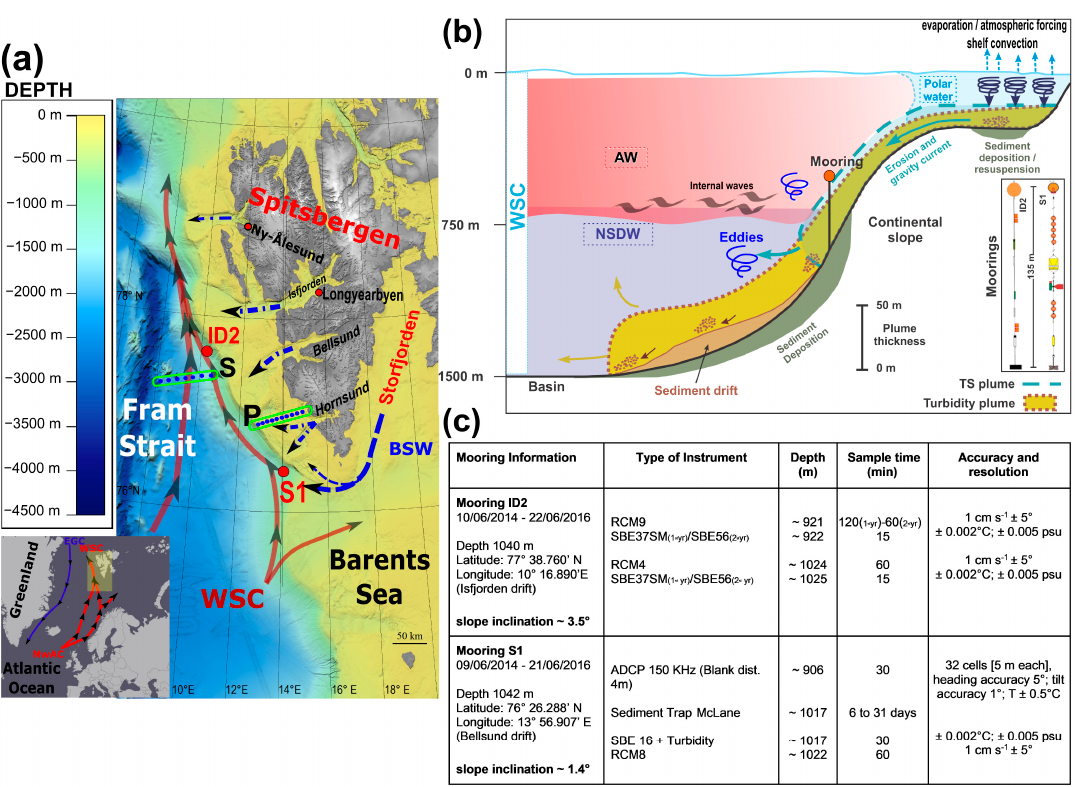
Figure 1. ( a ) Map of the study region showing bathymetry and main currents in the Fram Strait and along the west Spitsbergen margin. Red dots indicate the location of moorings S1 and ID2. Blue dots indicate CTD (conductivity-temperature-depth) stations along transects S and P. ( b ) Schematic of the shelf-slope dynamics along the west Spitsbergen slope (figure modified from [6], © American Meteorological Society. Used with permission). ( c ) S1 and ID2 moorings configuration and specification of instruments. (AW = Atlantic Water; NSDW = Norwegian Sea Deep Water; WSC = West Spitsbergen Current; BSW = Brine-enriched Shelf Water; EGC = East Greenland Current; NwAC = Norwegian Atlantic